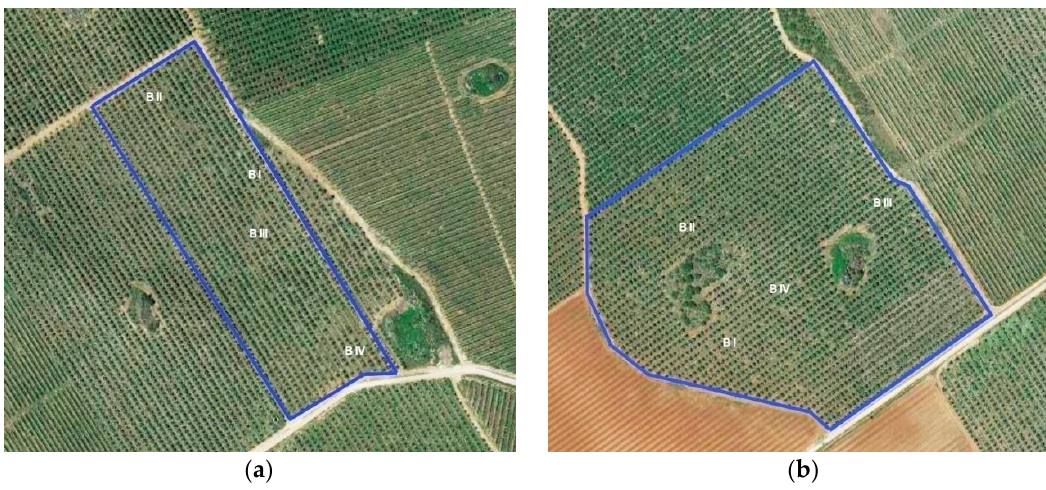
Figure 1. Geographical distribution of sampling blocks (total of four different blocks, from B I to B IV) considered for both ‘Cobrançosa’ ( a ) and ‘Galega Vulgar’ ( b ) cultivars. Both olive cultivars were collected at Torre das Figueiras—Sociedade Agrícola (Monforte, Portugal).